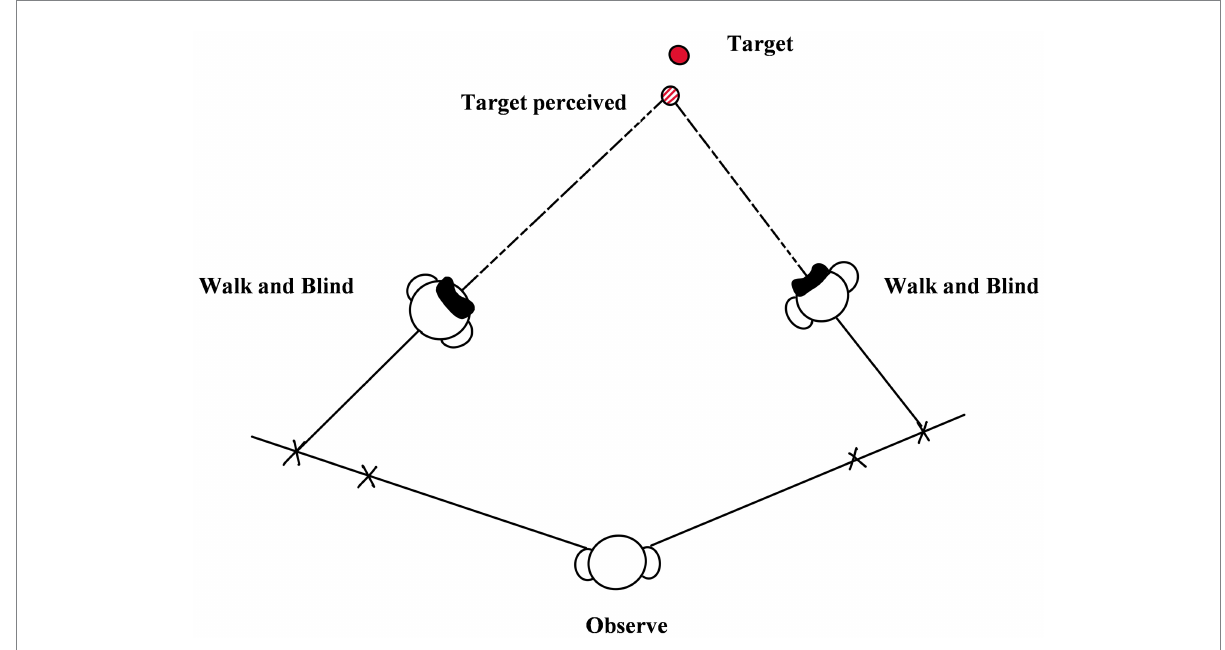
FIGURE 9 The diagram of triangulation-by-walking [referenced and modified from Fukusima et al.,